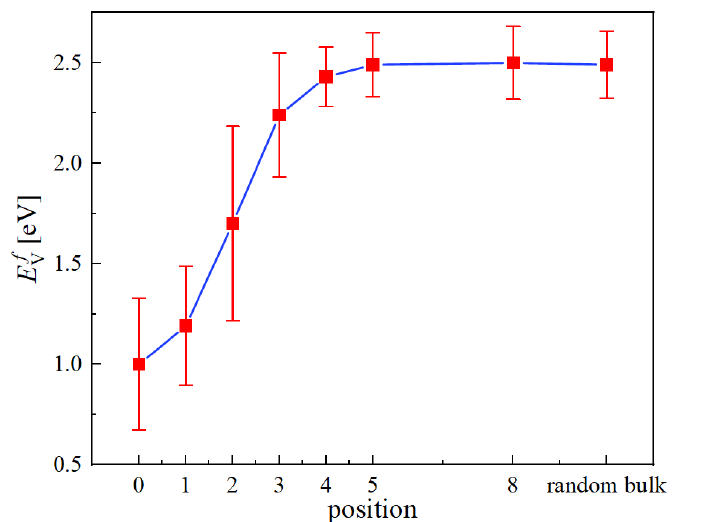
Figure 10. Vacancy formation energies as a function of distance from the edge dislocation core. The labeled positions in the x axis refer to the locations shown in Figure 9. The point labeled as ’random bulk’ gives the formation energy obtained in Section 3.3.